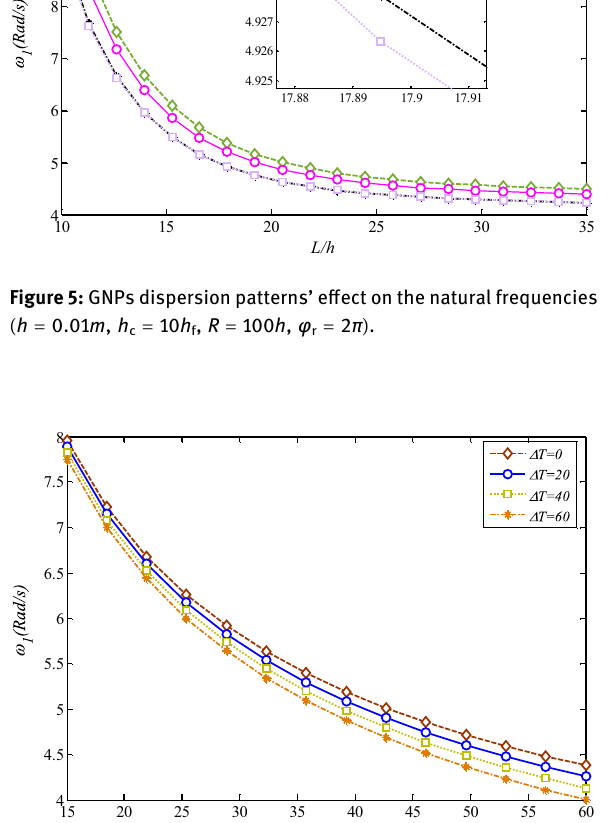
= 10 h L = 20 h , φ c f ,